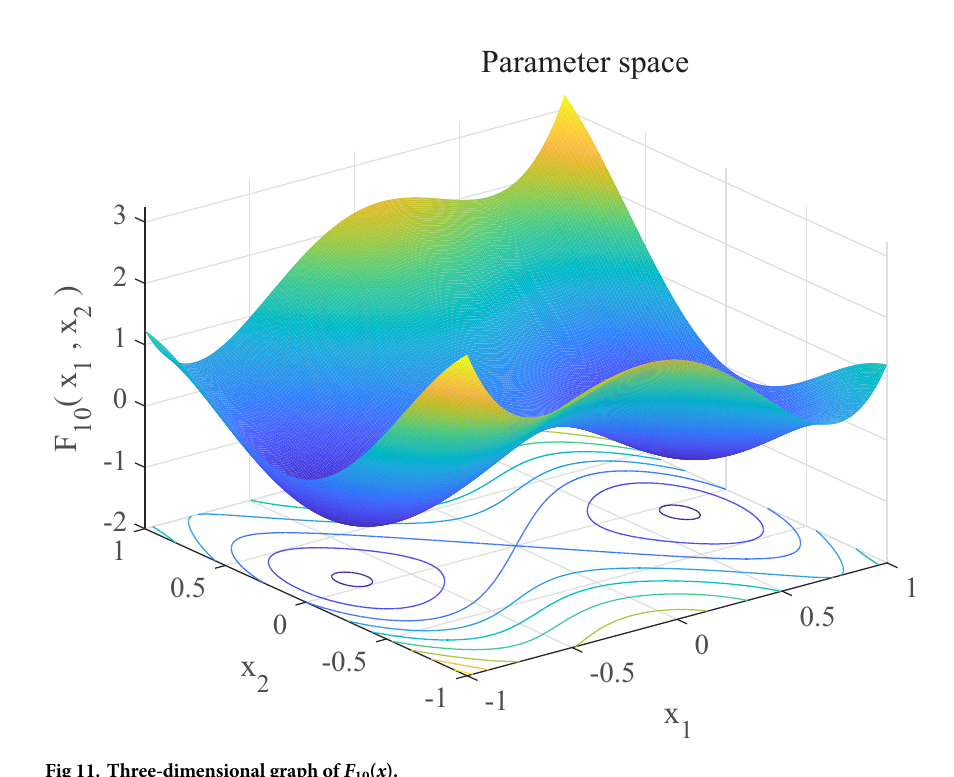
Fig 11. Three-dimensional graph of F 10 ( x ).